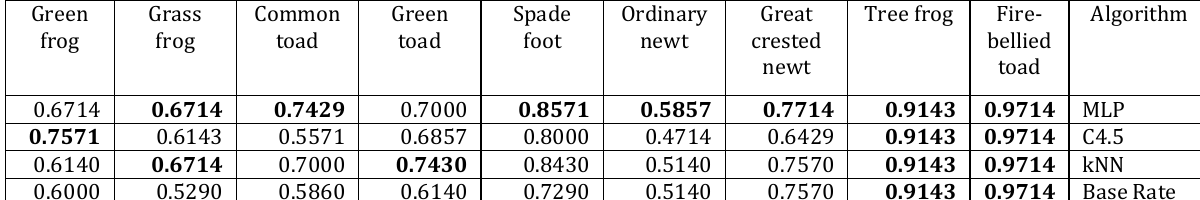
Table 2. The accuracy average results for each